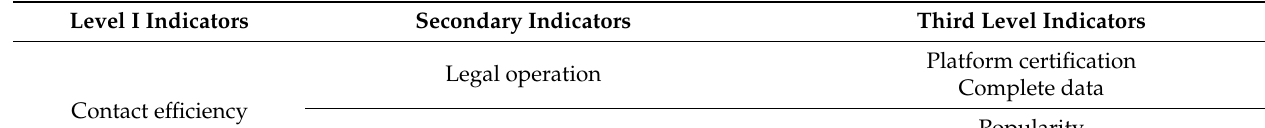
Table 2. Evaluation Index Framework of New Media for Environmental Protection Education from the Perspective of Ideological and Political